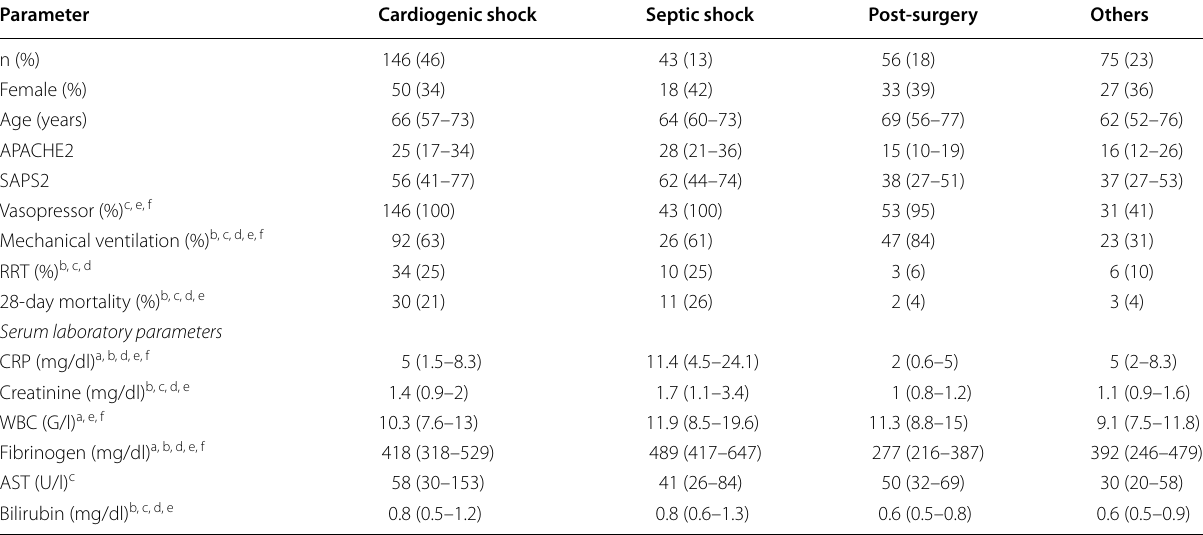
Data are shown as median and